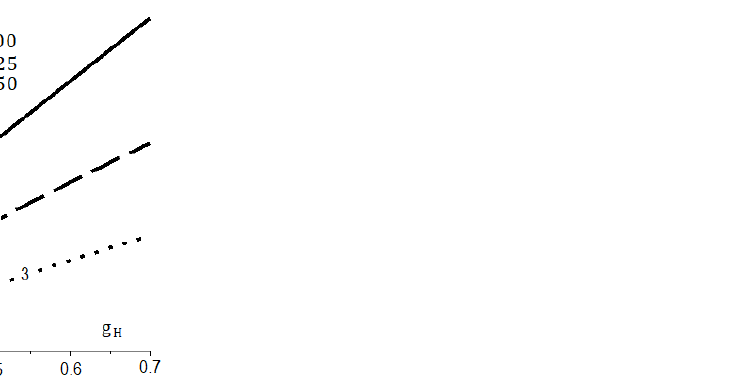
Figure 9. Dependence between the mean log temperature difference at the cold side and the dimen- sionless thermal conductance at the hot ∆ T C = f ( g H ).